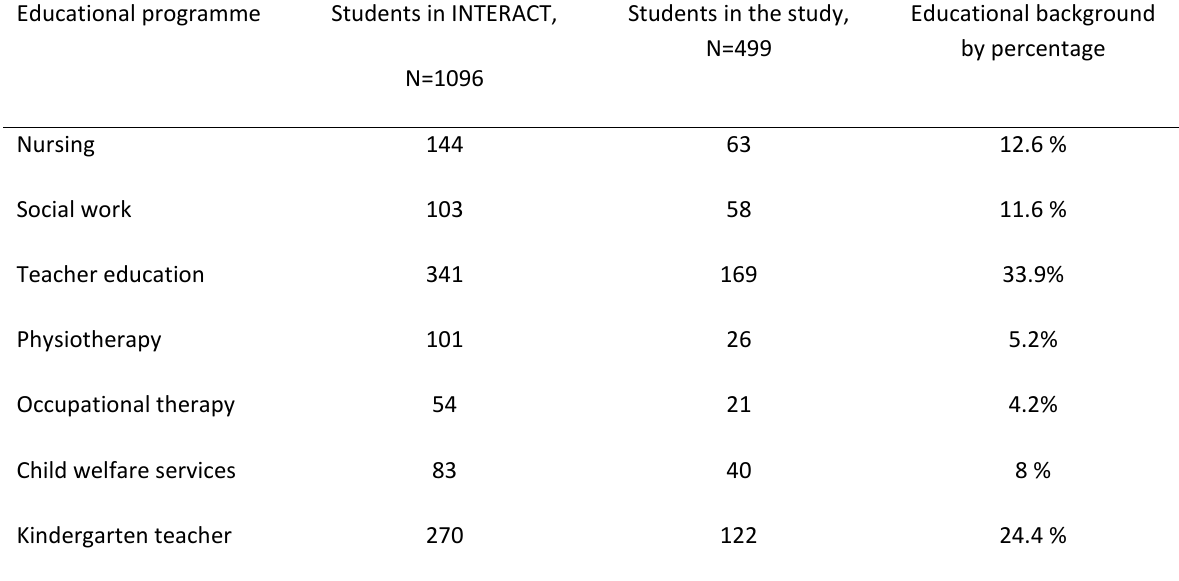
Table 1. The total number of students enrolled in the INTERACT programme, the number of students participating in the current study, and the percentage of students from the different educational programmes participating in the study.